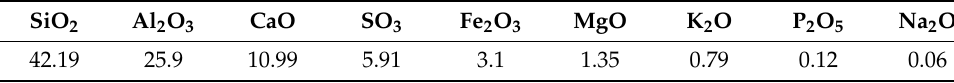
Table 2. Main chemical composition of desulfurization ash (%).